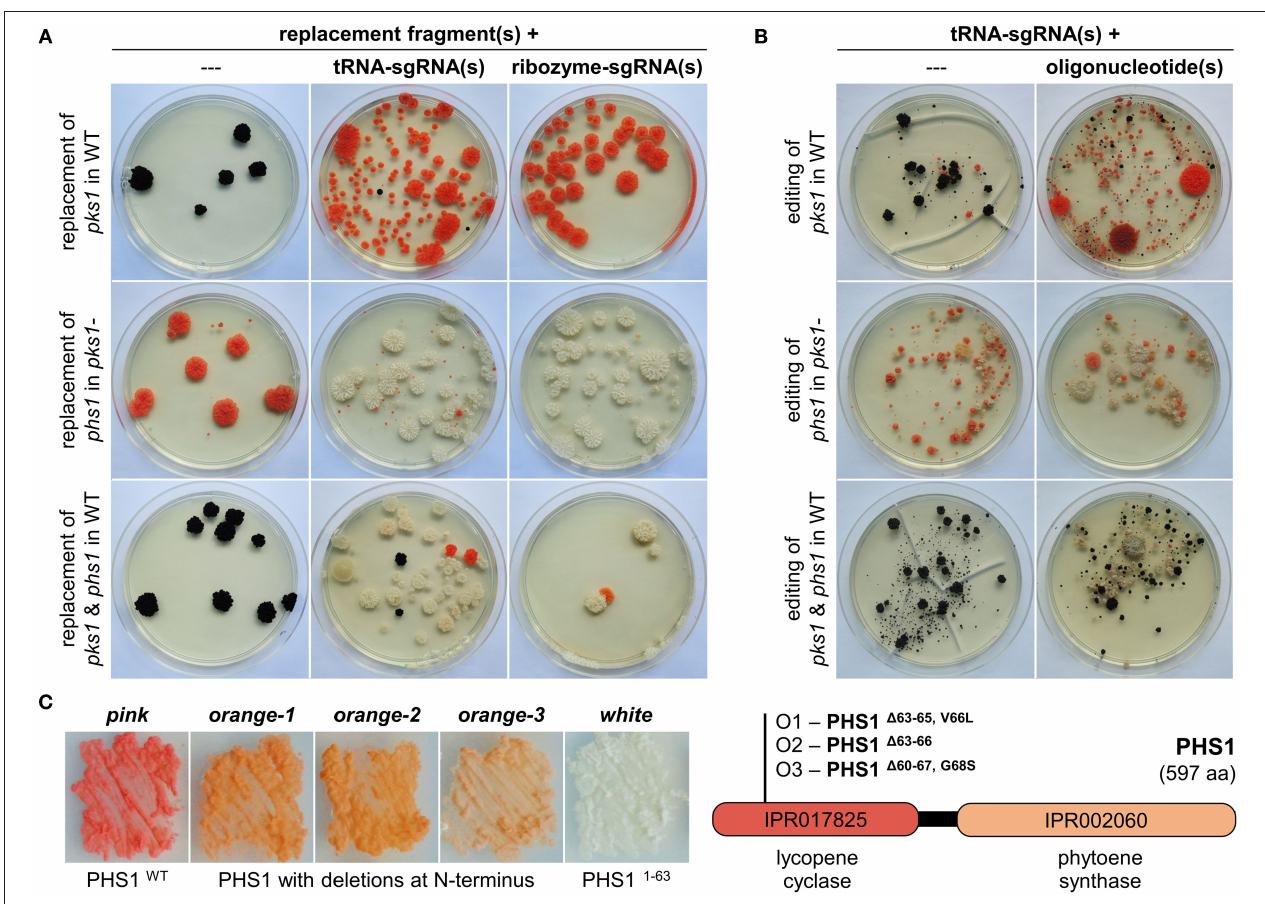
FIGURE 2 | CRISPR/Cas9-assisted mutations using sgRNAs liberated from tRNA splicing cassettes in K. petricola . (A) The expression of two sgRNAs from a tRNA splicing cassette increases the rate of double replacement mutants. Essential genes for pigment synthesis were targeted to compare efficiencies of sgRNA(s) released from tRNA splicing cassettes (this study, Supplementary Table 3 ) and ribozyme cassettes ( Voigt et al., 2020) of AMA1-bearing CRISPR/Cas9 plasmids: replacement of pks1 in WT for pink mutants, replacement of phs1 in melanin-deficient pks1- for white mutants, and double replacement of pks1 and phs1 in WT for white mutants. Short-homology (SH) replacement fragments for pks1 with natR cassette and phs1 with hygR cassette were amplified by PCR. Protoplasts were transformed with donor DNA alone (negative controls; 1D, 2D, 3D) or in combination with AMA1-containing plasmids expressing Cas9 and respective sgRNAs from tRNA splicing cassettes (tRNA-sgRNA; 1C, 2C, 3C) or ribozyme cassettes (ribozyme-sgRNA; RC1, RC2, RC3) as specified in Supplementary Table 4 . Regenerated protoplasts were overlaid with agar supplemented with NTC ( 1 pks1 ), HYG ( 1 phs1 ) or both ( 1 pks1 / 1 phs1 ). Representative transformation plates after 5 weeks of incubation are shown. For summary of the results of three independent experiments see Supplementary Figure 3A . (B) sgRNAs from tRNA splicing cassettes mediate efficient double gene editing when combined with oligonucleotides. WT and pks1 - protoplasts were transformed with pAMA/tRNA- pks1 PS2 , pAMA/tRNA- phs1 PS1 , or